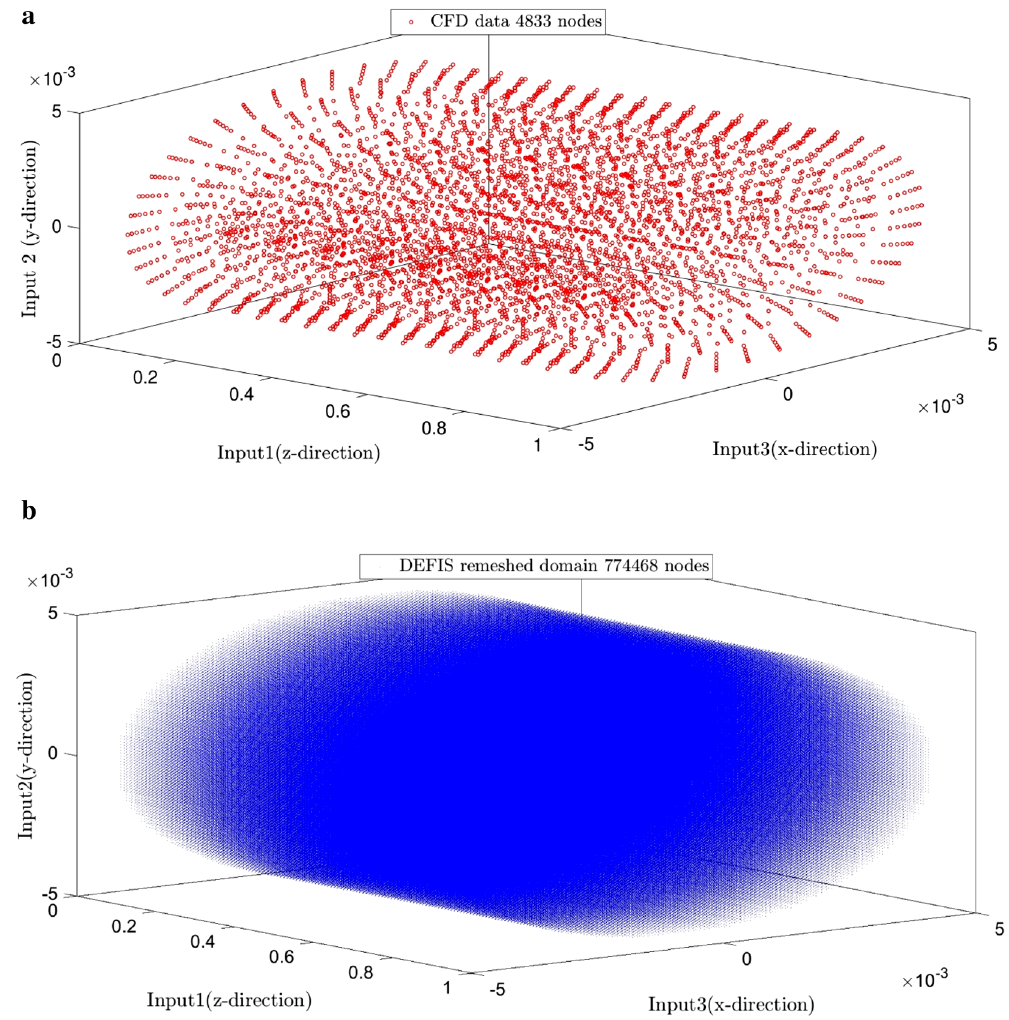
Figure 8. ( a ) CFD domain nodes. ( b ) Remeshed DEFIS domain